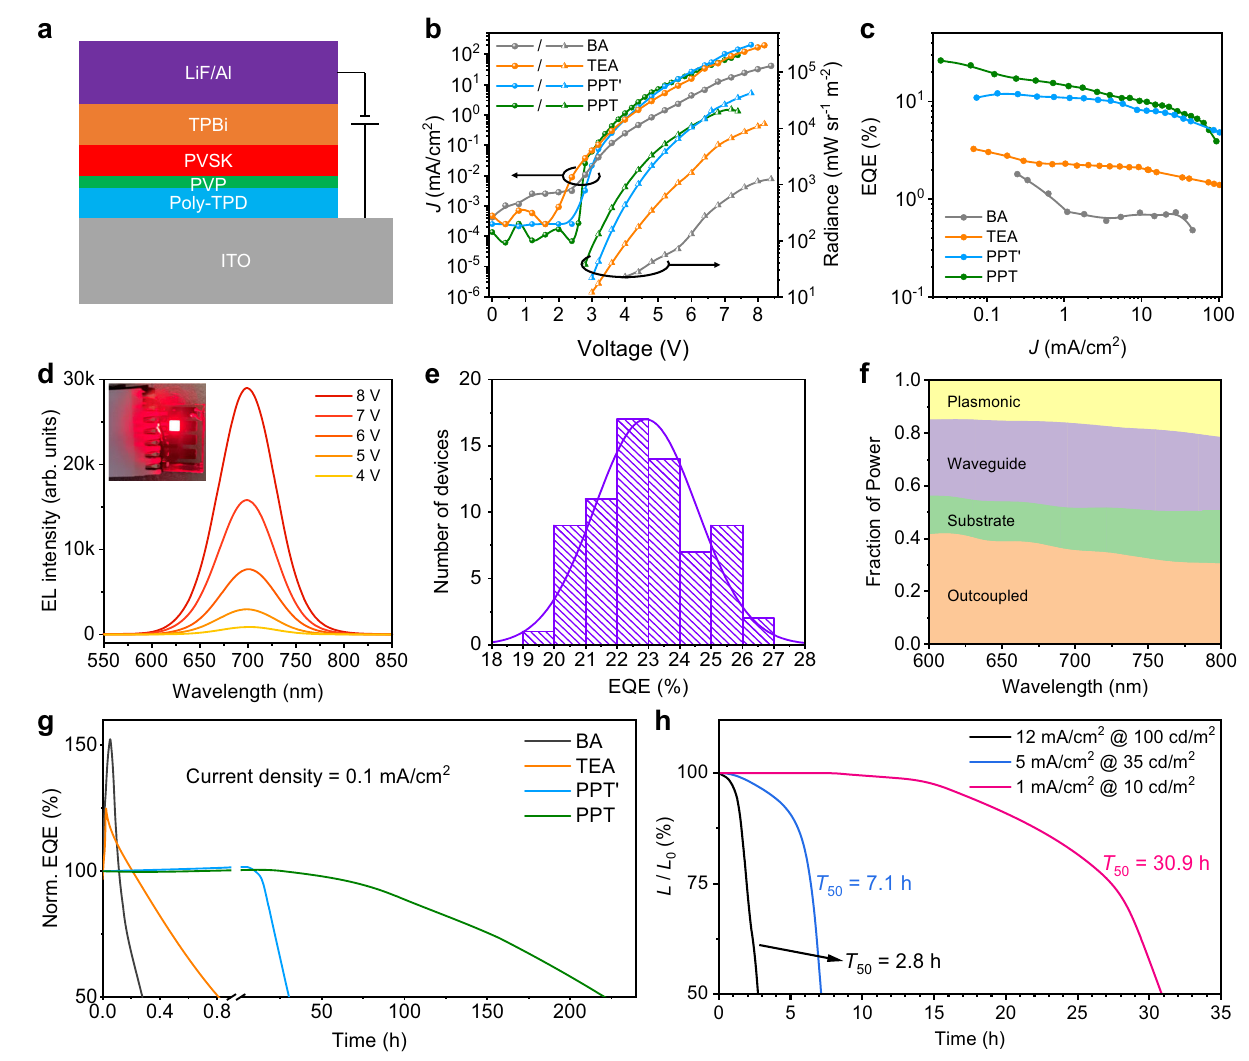
Fig. 4 | Device performance of distribution controlled quasi-2D perovskite LEDs. a Device architecture. PVSK indicates the quasi-2D perovskites investigated in this work. b , c Current density-voltage-radiance ( J - V - R ) curves ( b ) and EQE characteristic( c )ofquasi-2DperovskiteLEDs. d ELspectraunderforwardbiasesof 4, 5, 6, 7 and 8V. Inset is a photograph of a working device. e Histogram of EQEs measured from 70 devices, which gives an average value of 22.9% and a relative